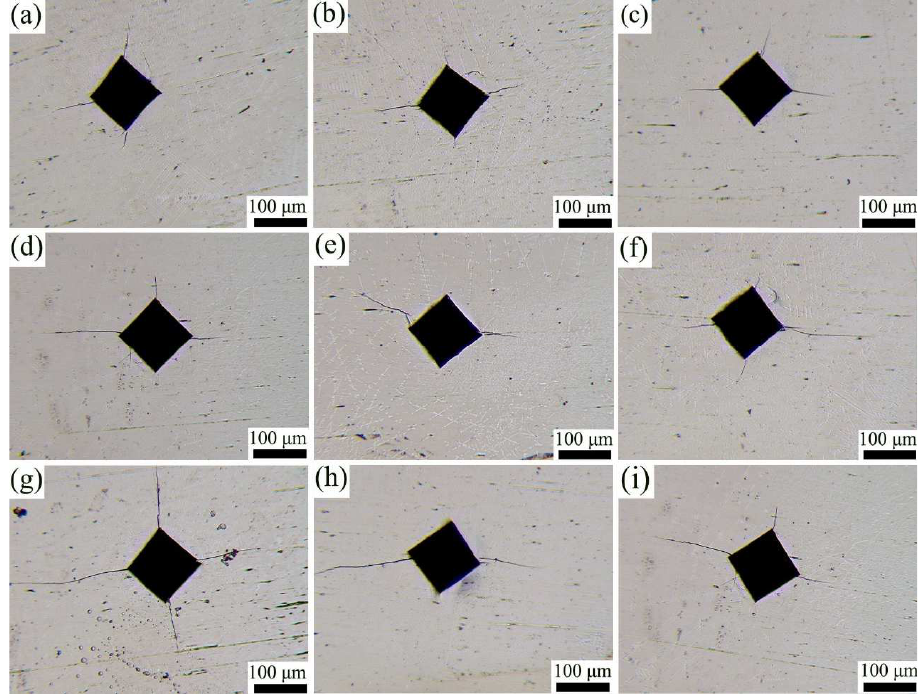
Figure 6. OM images of the Vickers indentations obtained in the middle zones with the same distance from the surface in the cross sections of coatings: ( a – c ) Al 0.5 , ( d – f ) Al 1.0 , and ( g – i ) Al 1.5 .